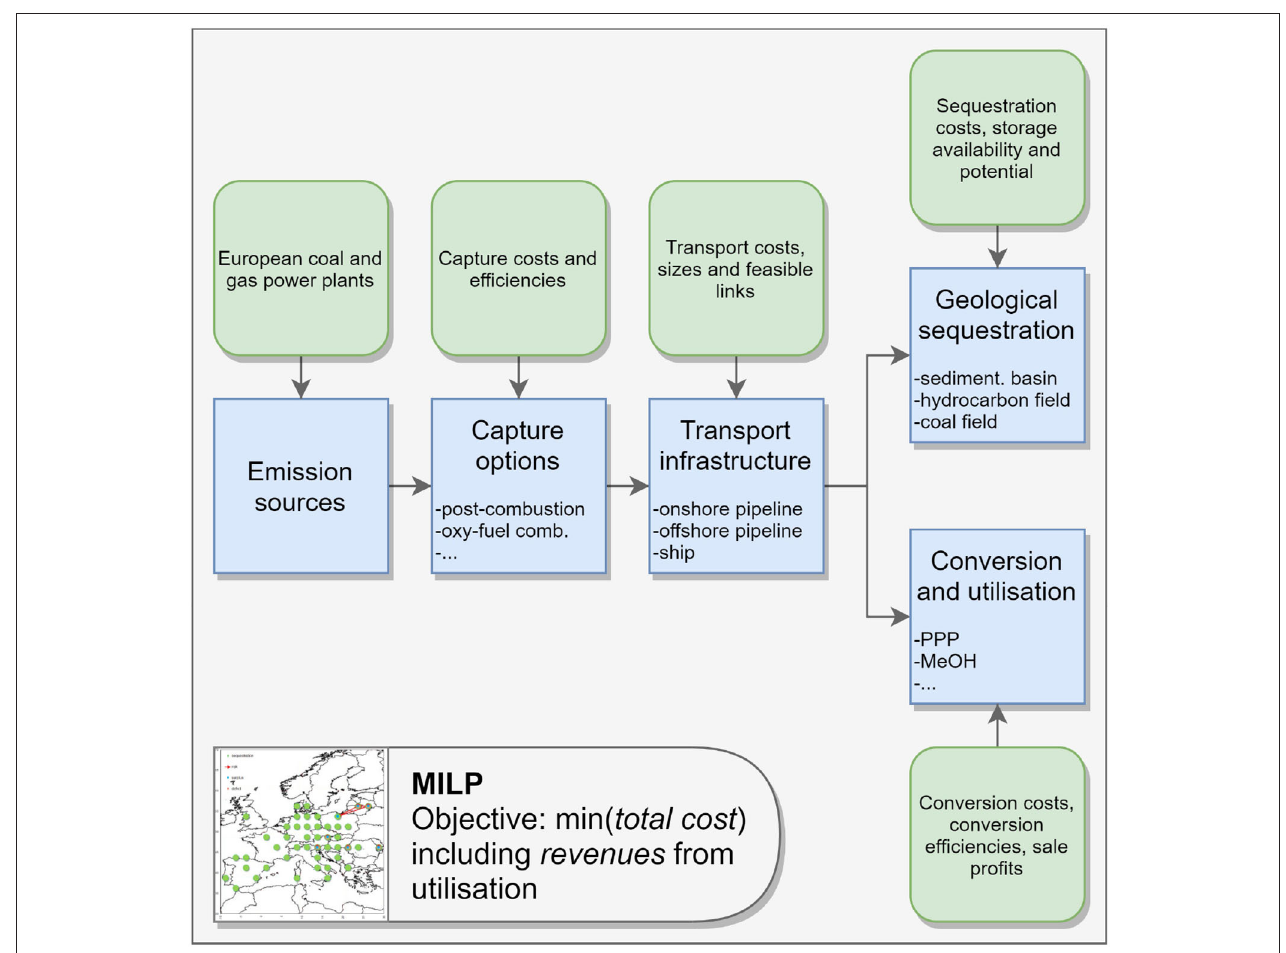
FIGURE 1 | Overview of the proposed framework for the CCUS SC